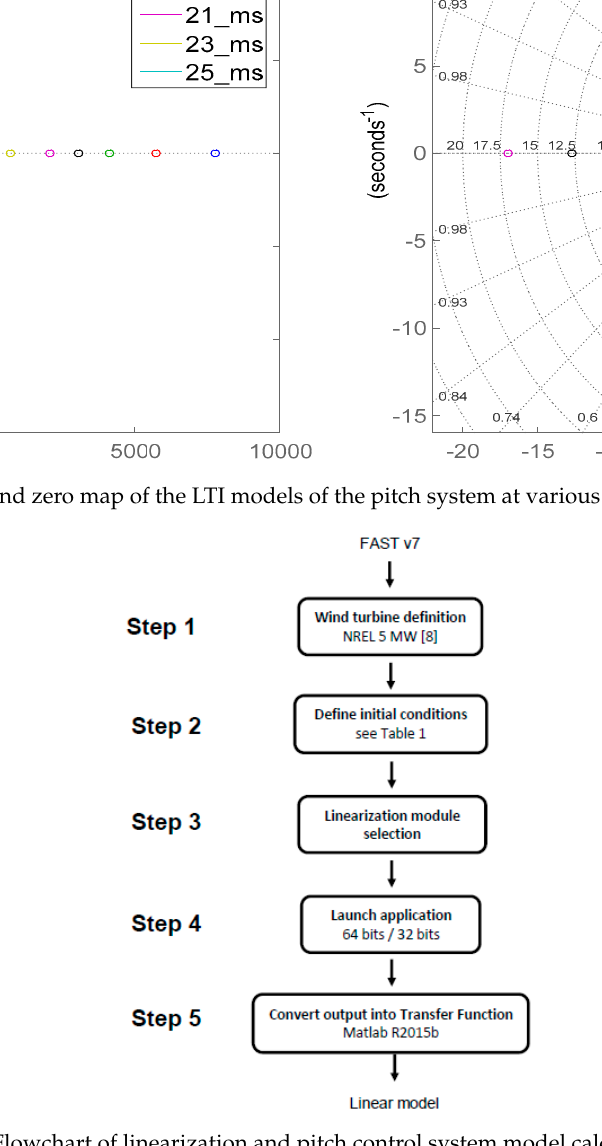
Figure 3. Flowchart of linearization and pitch control system model calculation process.